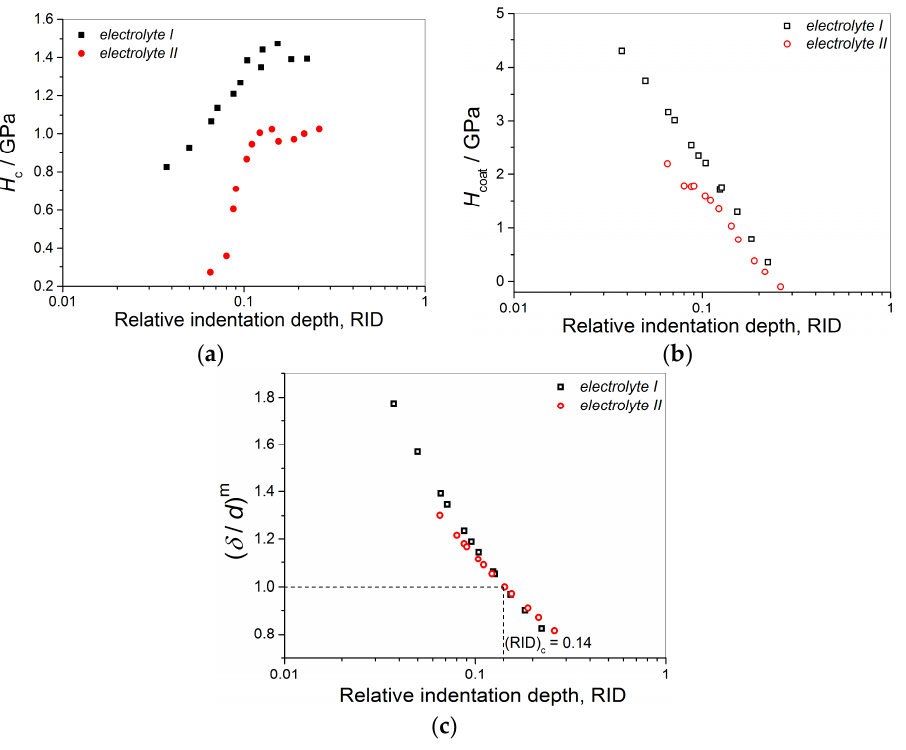
Figure 11. The dependencies of ( a ) the composite ( H c ) and ( b ) the calculated coating ( H coat ) hardness on the RID for the 40 µm thick Cu coatings electrodeposited on the Si(111) from electrolytes I and II , and ( c ) the dependencies of ( δ / d ) m on the RID for the same Cu coatings. The dependencies of the ( δ / d ) m on the RID for the formed coatings are presented in Figure 11c. The values of m parameters were 0.4290 for the mat Cu coating obtained